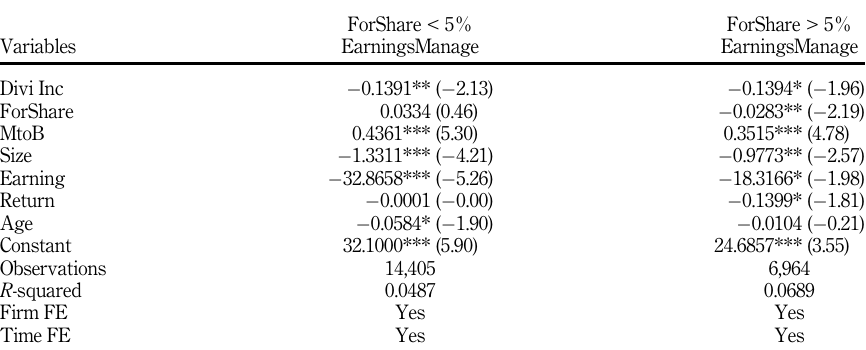
share greater or less than